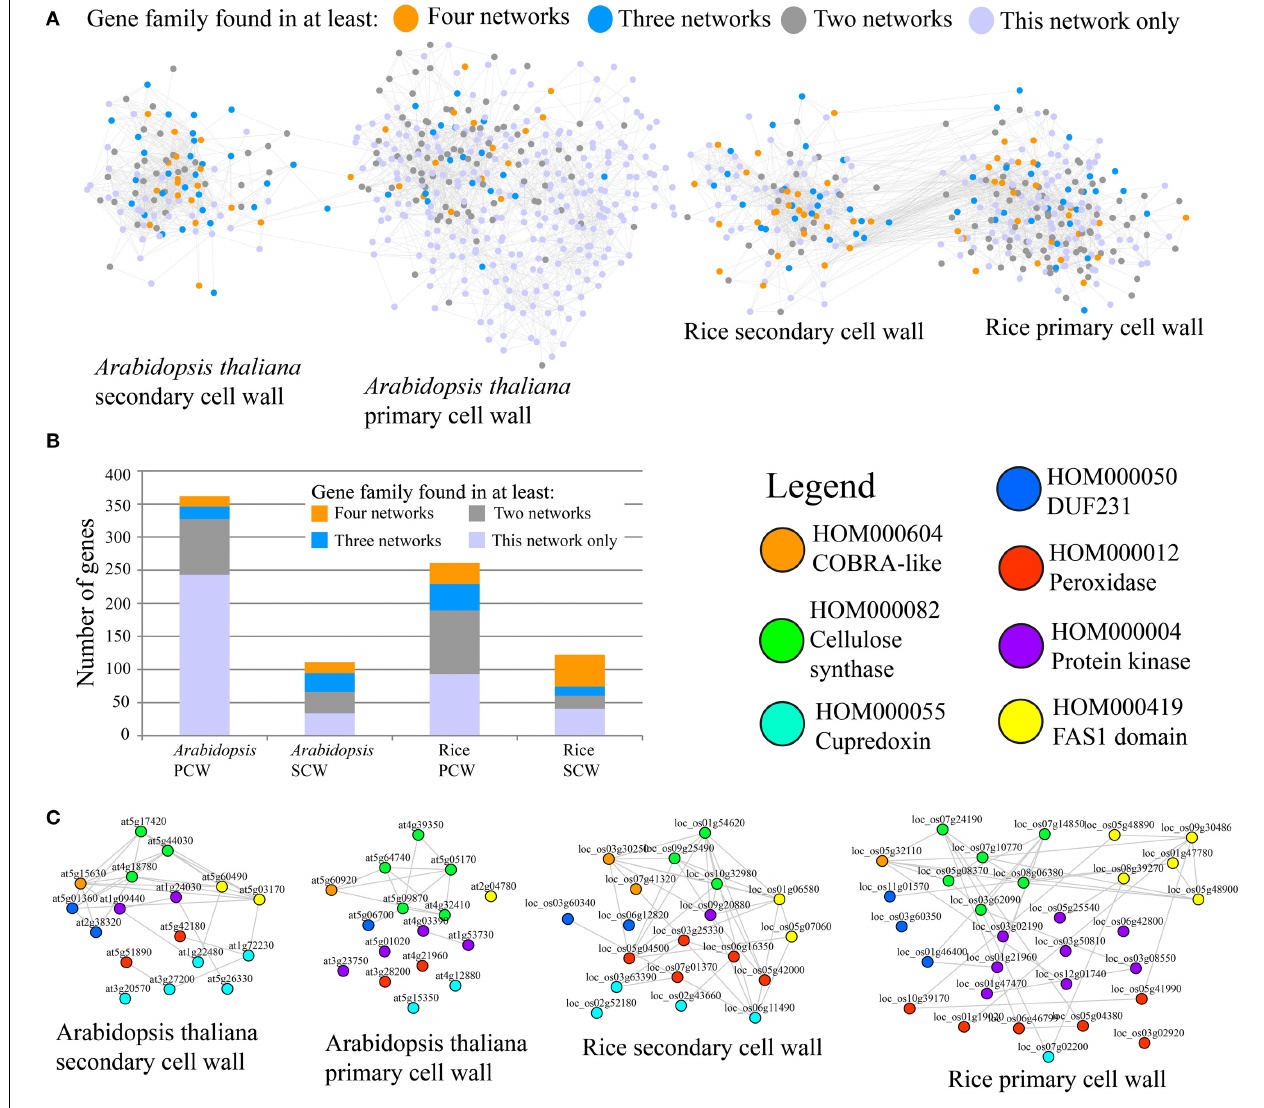
networks. The y-axis represents total number of genes, while the x-axis represents the four analyzed cell wall networks. Color of the bars depict degree of conservation. (C) Filtered PCW and SCW networks where genes that belong to families present in all four networks are shown. Nodes are color-coded according to the family they belong